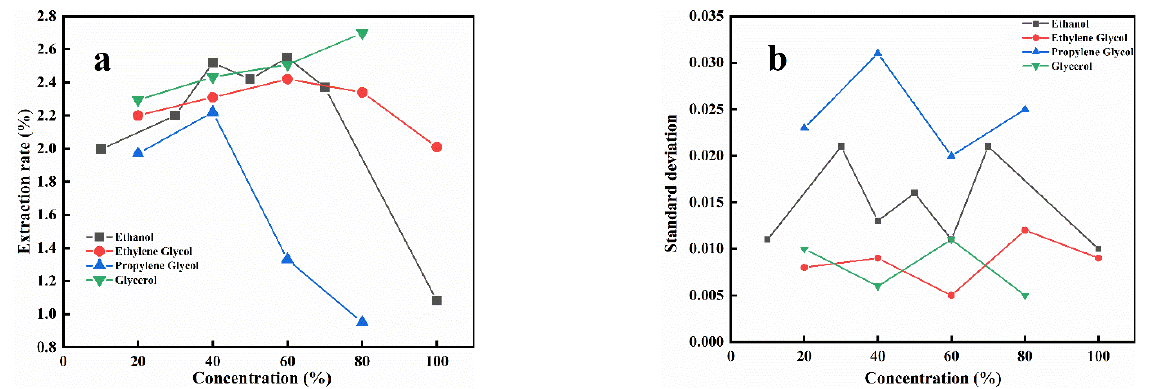
Figure 2. ( a ) Effects of alcohols with different hydroxyl numbers on the extraction rate of CGA. ( b ) Standard deviation of the effect of the number of hydroxyls on the extraction